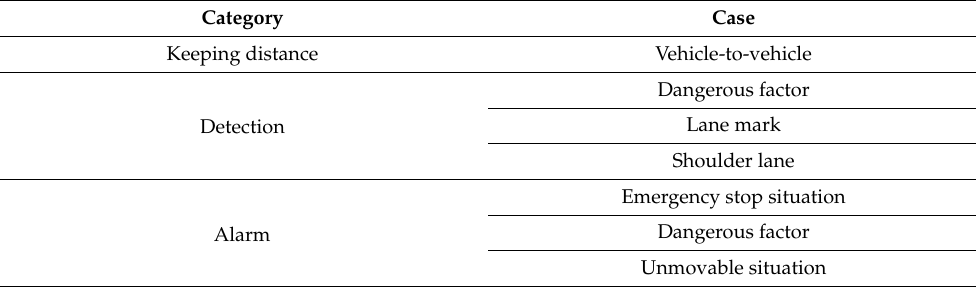
Table 11. Scenario selection—tunnel.